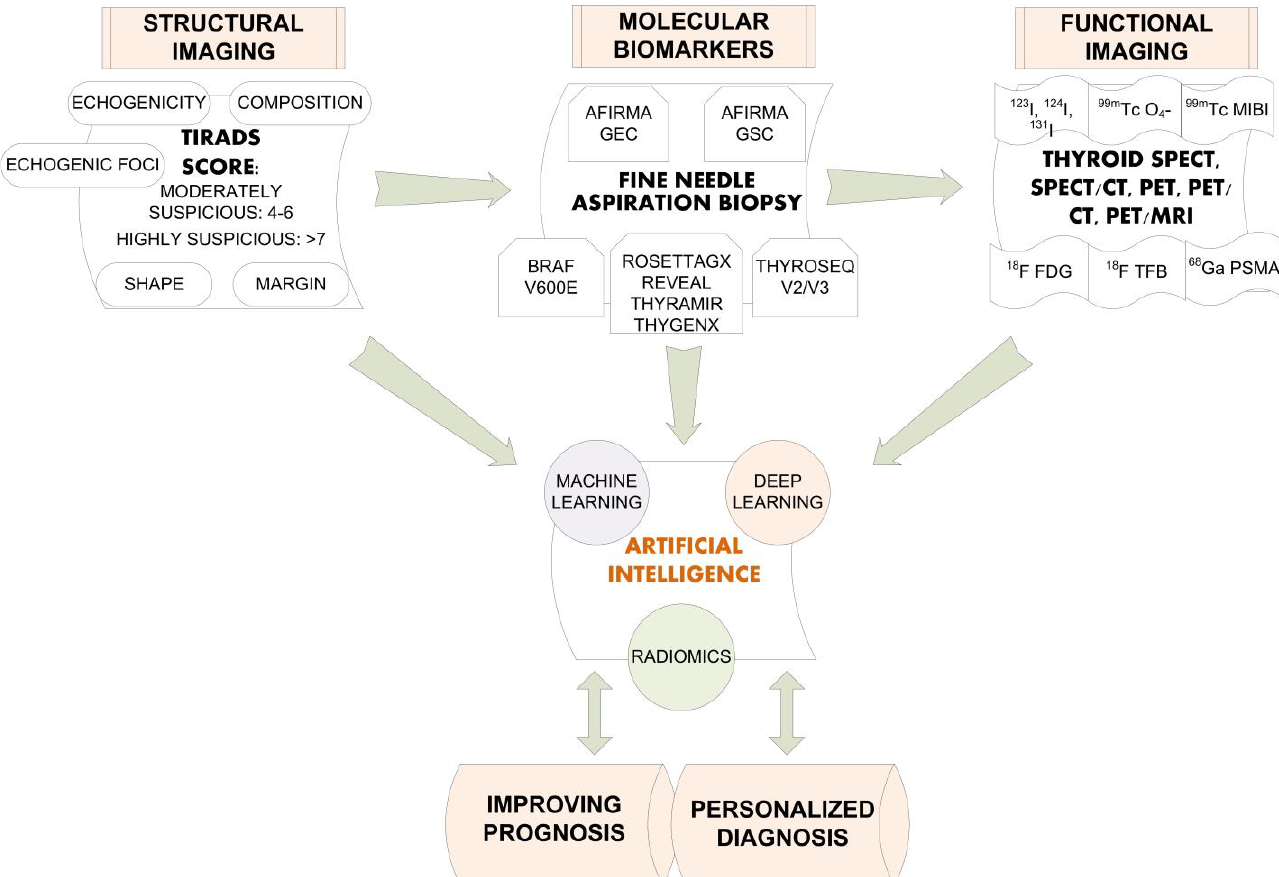
Figure 5. Proposed algorithm for the diagnosis of differentiated thyroid